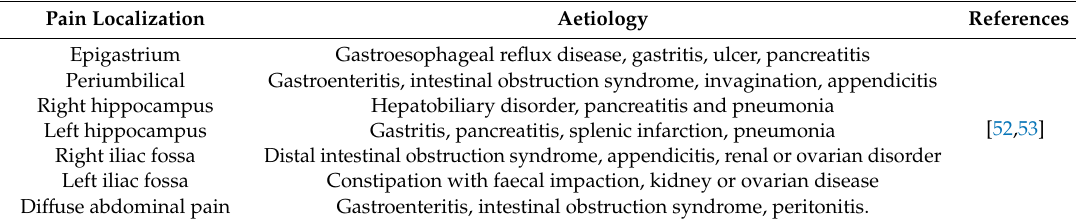
Table 4. Relationship between abdominal pain localization and